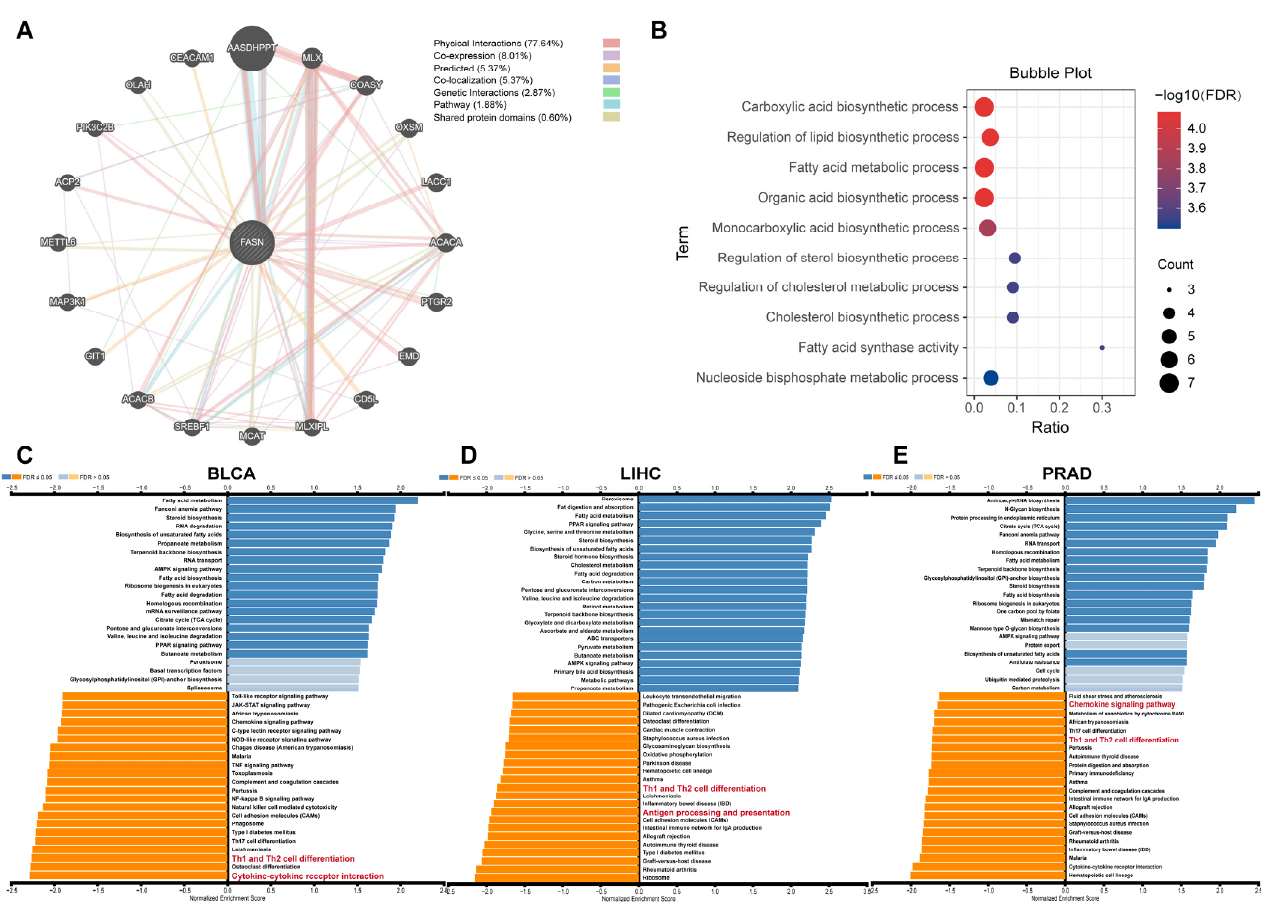
Figure 10. FASN interacting molecules and functional enrichment analysis. Analysis of various molecules ( A ) interacting with FASN and functional enrichment analysis ( B ) of FASN using Gene- MANIA. FASN enrichment KEGG pathways in BLCA ( C ), LIHC ( D ), and PRAD ( E ) were analyzed by GSEA.